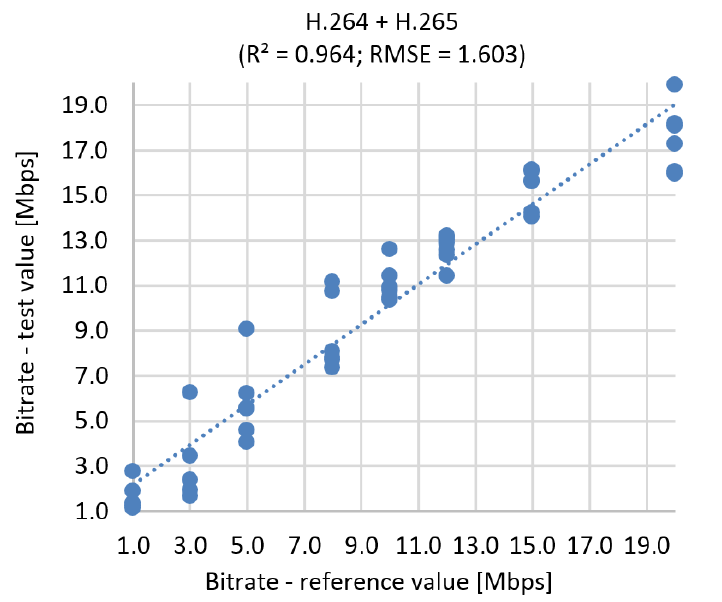
Figure 21. Correlation diagram for bitrate prediction based on SSIM, Ultra HD , H.264 + H.265.